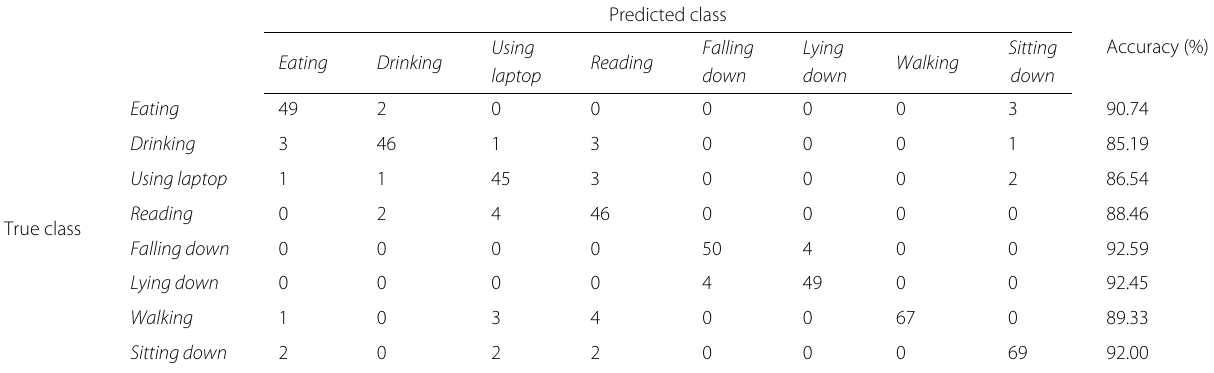
Table 3 Confusion matrix for the test set of Dataset-A